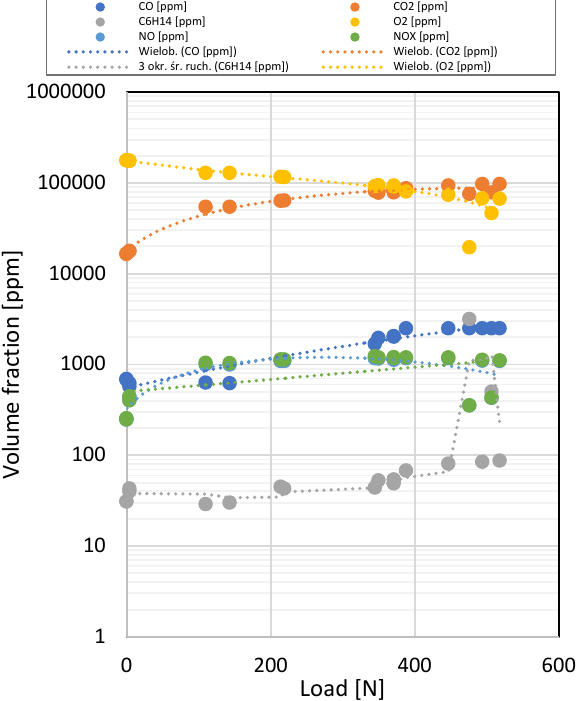
Fig. 11. Exhaust gases composition as a function of engine load during operation in 1500 rpm